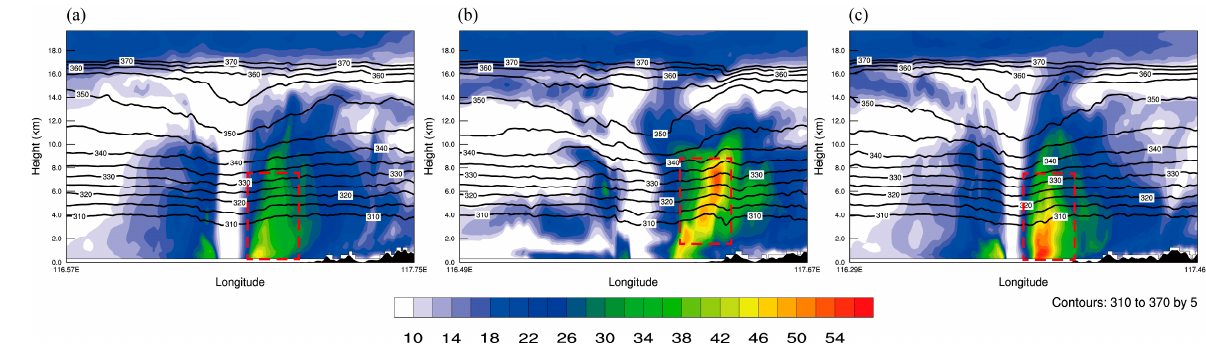
Figure 9. Vertical profiles of the horizontal wind speed (shaded, unit: m s − 1 ) and potential temperature (black contours, unit: K) in the ( a ) CTRL, ( b ) DA_len1.0 and ( c ) DA_len0.25 experiments at 0000 UTC on 9 July 2015.